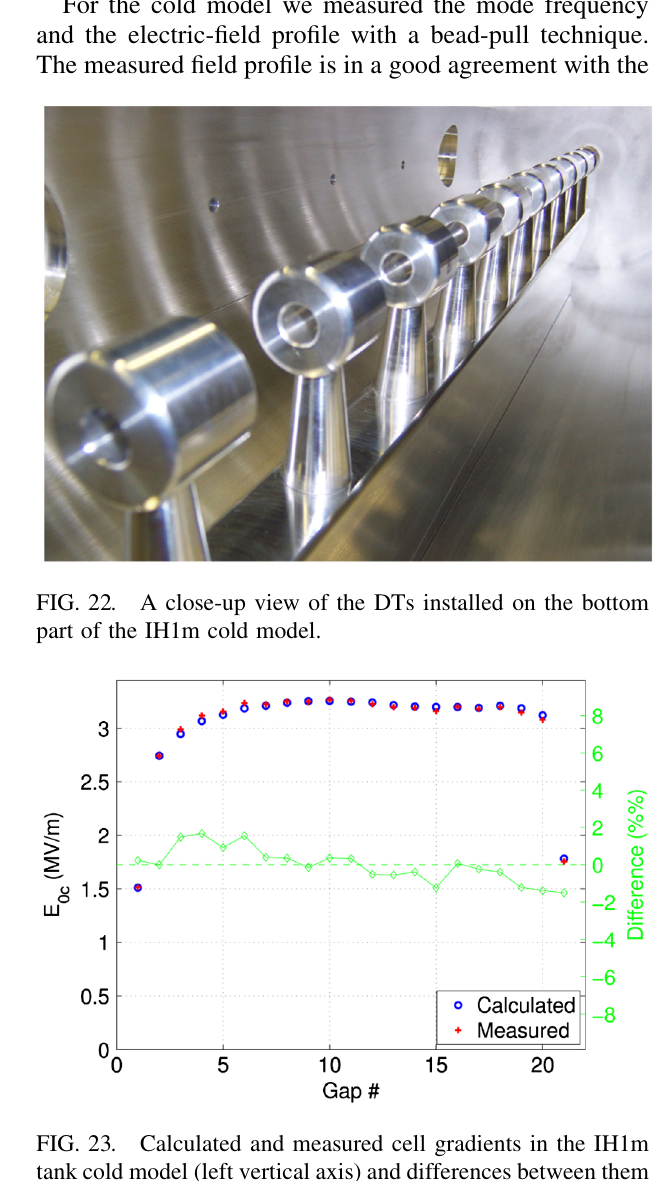
FIG. 21. An exploded view of the tank cold model. Two pairs of slug tuners are located on the side panels.